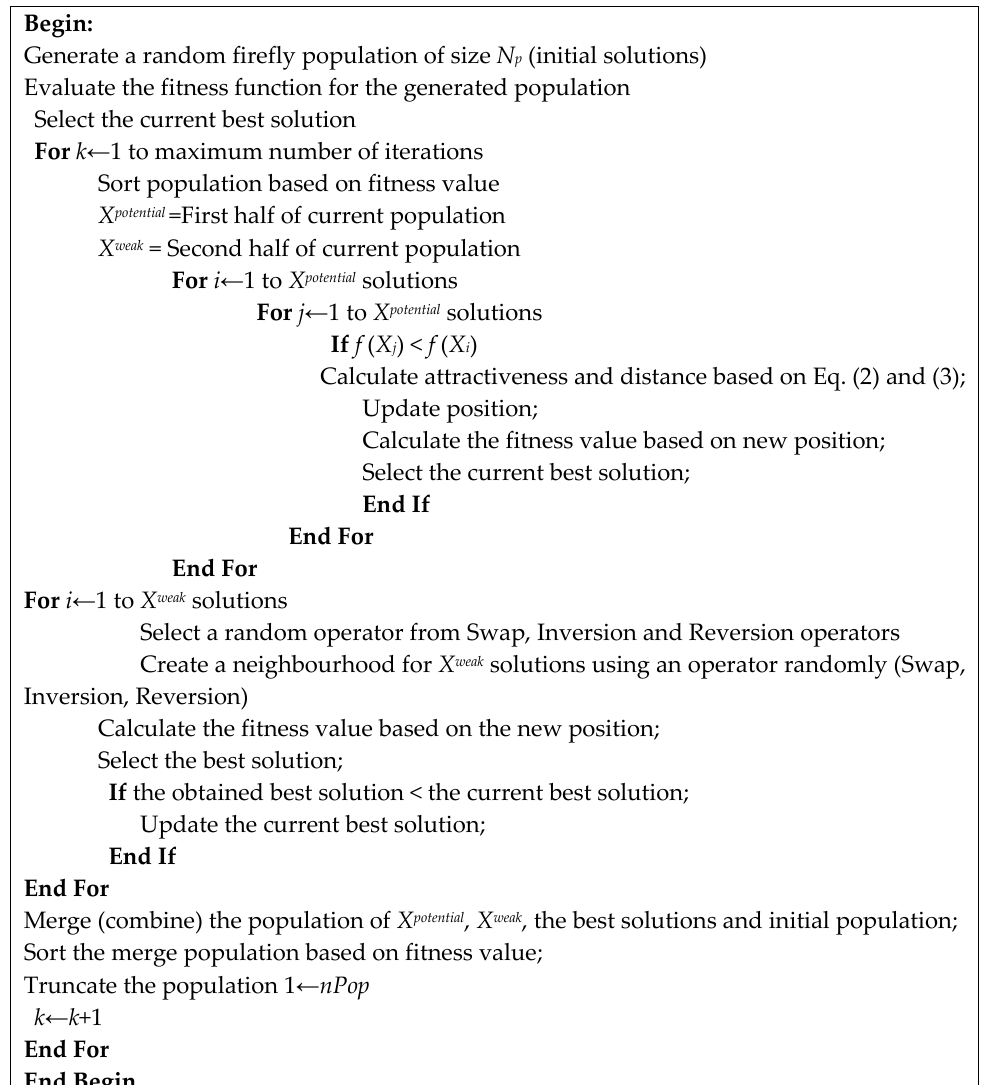
Figure 2. Pseudo code for modified FA. Figure 3. Pseudo code for modified